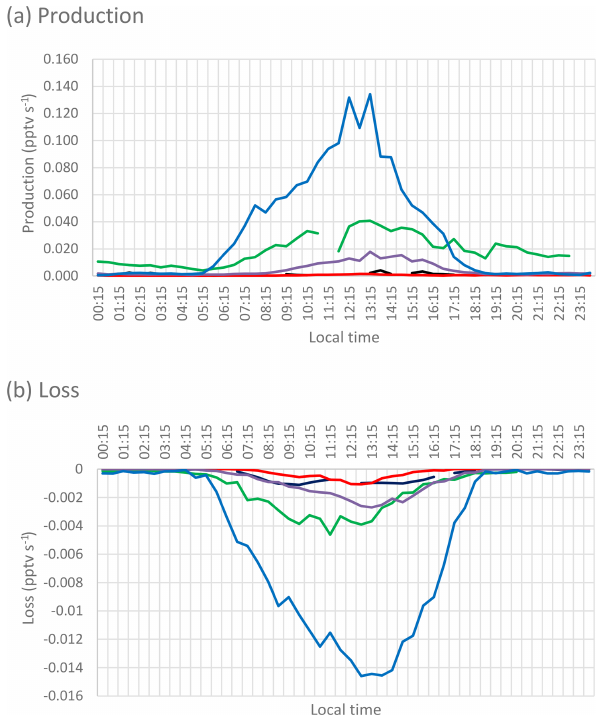
Figure 5. Photochemical production and loss of H 2 O 2 in pptvs − 1 . Note that the time used is local